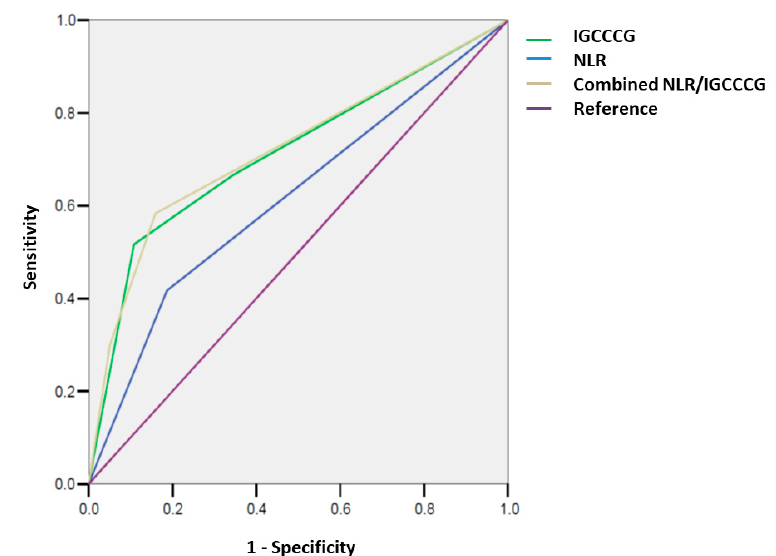
Figure 1. Kaplan–Meier curves of overall survival (OS) according to the IGCCCG group.